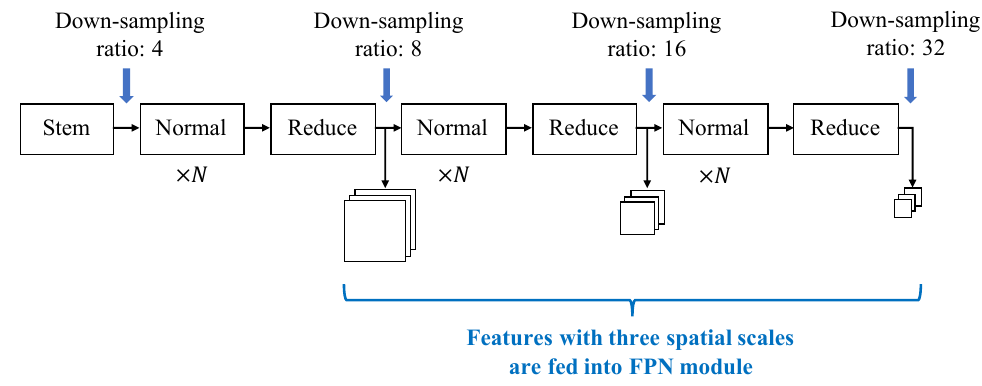
Figure 1. Macro architecture of the backbone supernet. Each cell is independently searched. N is the number of repeated normal cells, which affects the model